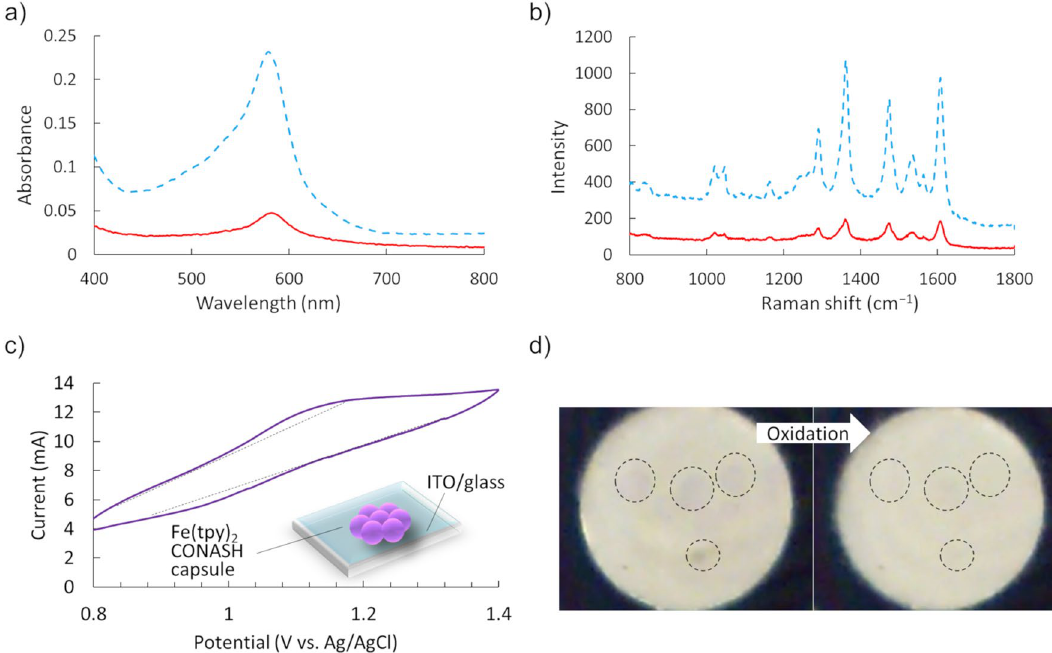
Figure 2. Electrochemical and spectral properties. ( a ) UV–Vis absorption spectra of Fe(tpy) 2 CONASH capsules (solid line) and a CONAH film (broken line). ( b ) Raman spectra of Fe(tpy) 2 CONASH capsules (solid line) and a CONASH film (broken line). ( c ) Cyclic voltammogram of Fe(tpy) 2 CONASH capsules and schematic of the capsules on an ITO electrode. ( d ) Images of Fe(tpy) 2 CONASH capsules oxidized